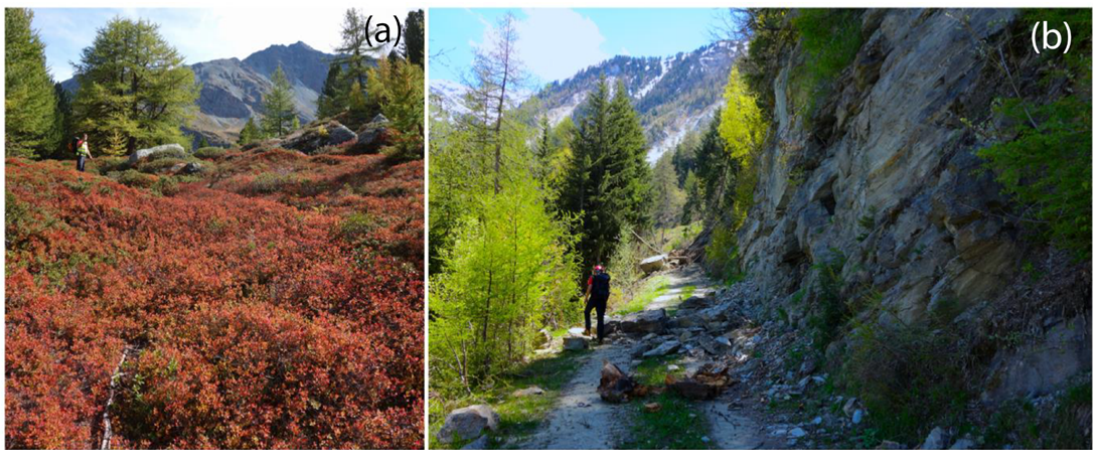
Figure 3. ( a ) Closed elongated depression at the top of the Böchtur hillslope, possibly indicating a Sackung-type failure of the bedrock, ( b ) local slope collapses near the bend of the road described in the text. Photos by B. McArdell, WSL.